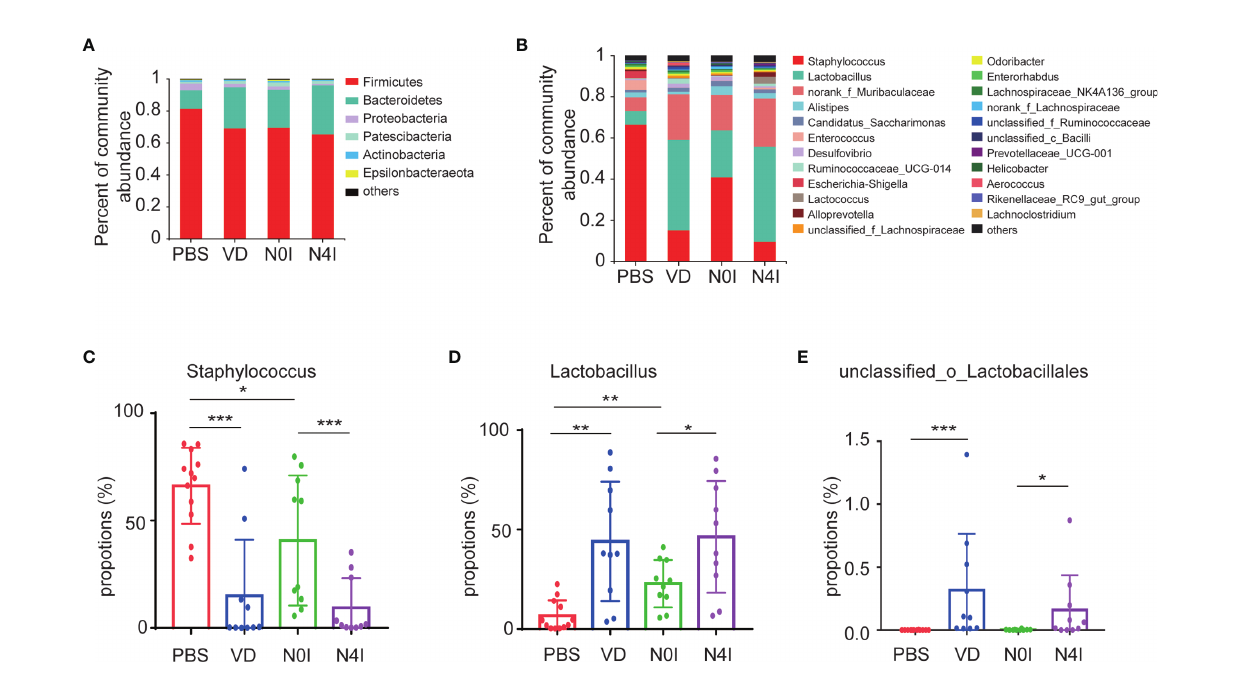
FIGURE 3 | Relative abundance of different bacteria in control, VD, and mCRAMP-encoding L. lactis – treated mice. Bacteria taxonomic pro fi ling at the phylum (A) and genus (B) levels of gut microbiota from control, VD, and mCRAMP-encoding L. lactis – treated mice were presented. (C – E) Bar graphs show the relative abundance of bacteria in control, VD, and mCRAMP-encoding L. lactis – treated mice. * p < 0.05; ** p < 0.01; *** p < 0.001. p < 0.05 indicates statistical signi fi cance using a nonparametric Mann-Whitney U